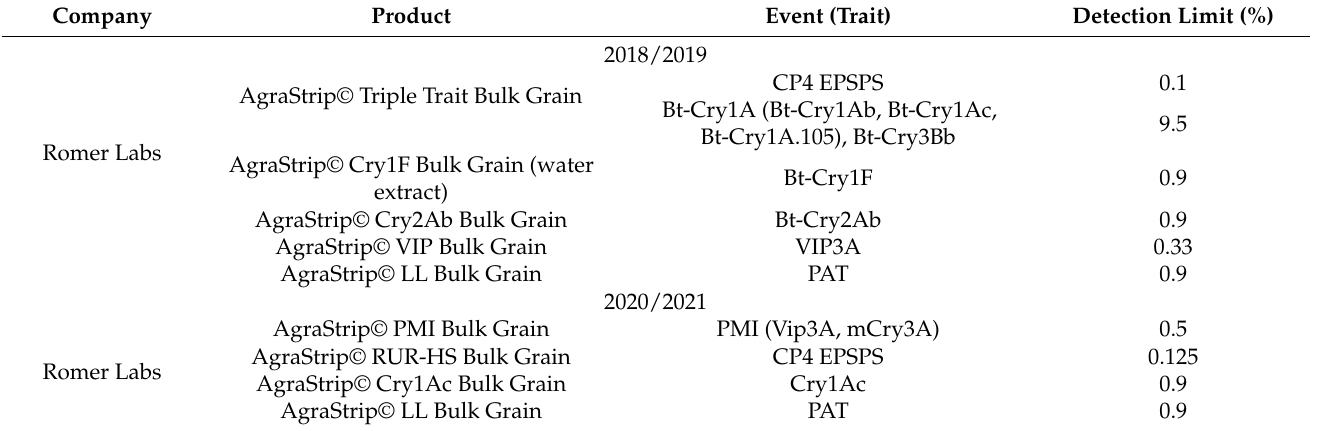
Table 3. Tests, proteins/trace, and detection limits used in each of the evaluation samples.